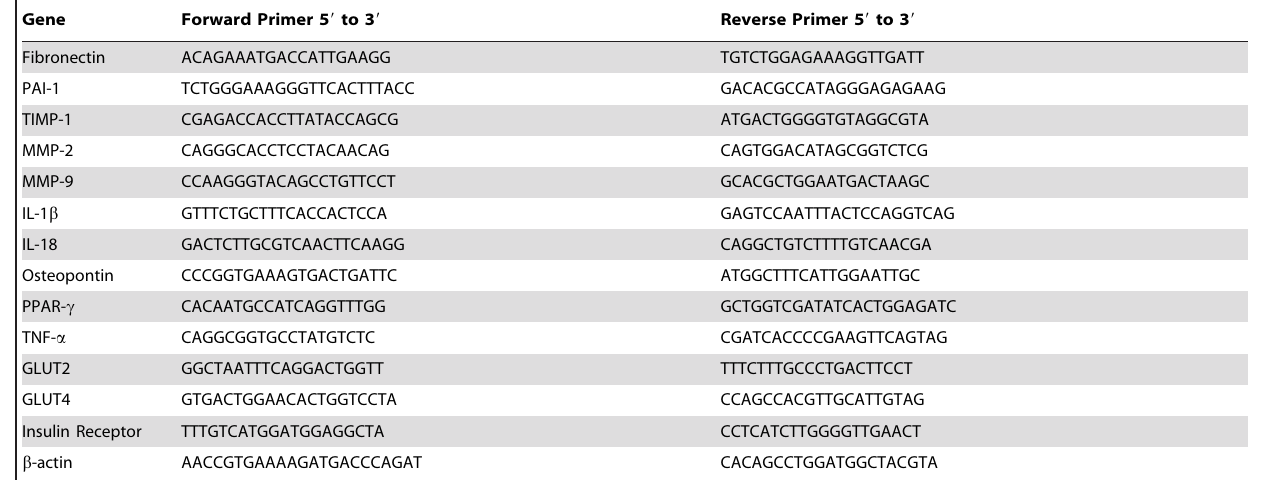
Table 1. Murine Primer Sequences.